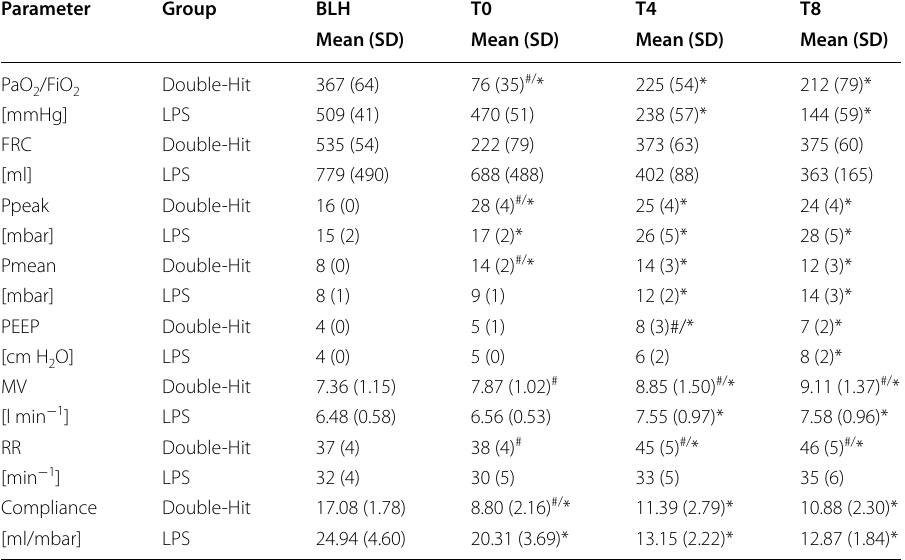
* Indicates p < 0.05 vs. baseline value. # indicates p < 0.05 in intergroup comparison PaO 2 : arterial oxygen; FiO 2 : fraction of inspired oxygen; PaO 2 /FiO 2 : oxygen index; FRC: functional residual capacity; MV: minute ventilation; Ppeak: peak inspiratory pressure; Pmean: mean airway pressure; PEEP: positive end‑expiratory